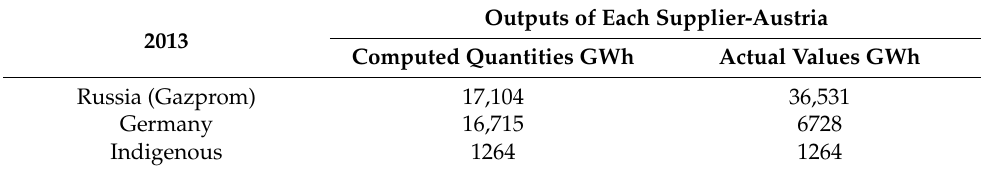
Table 6. Strategic output of each supplier—Austria, 2013.